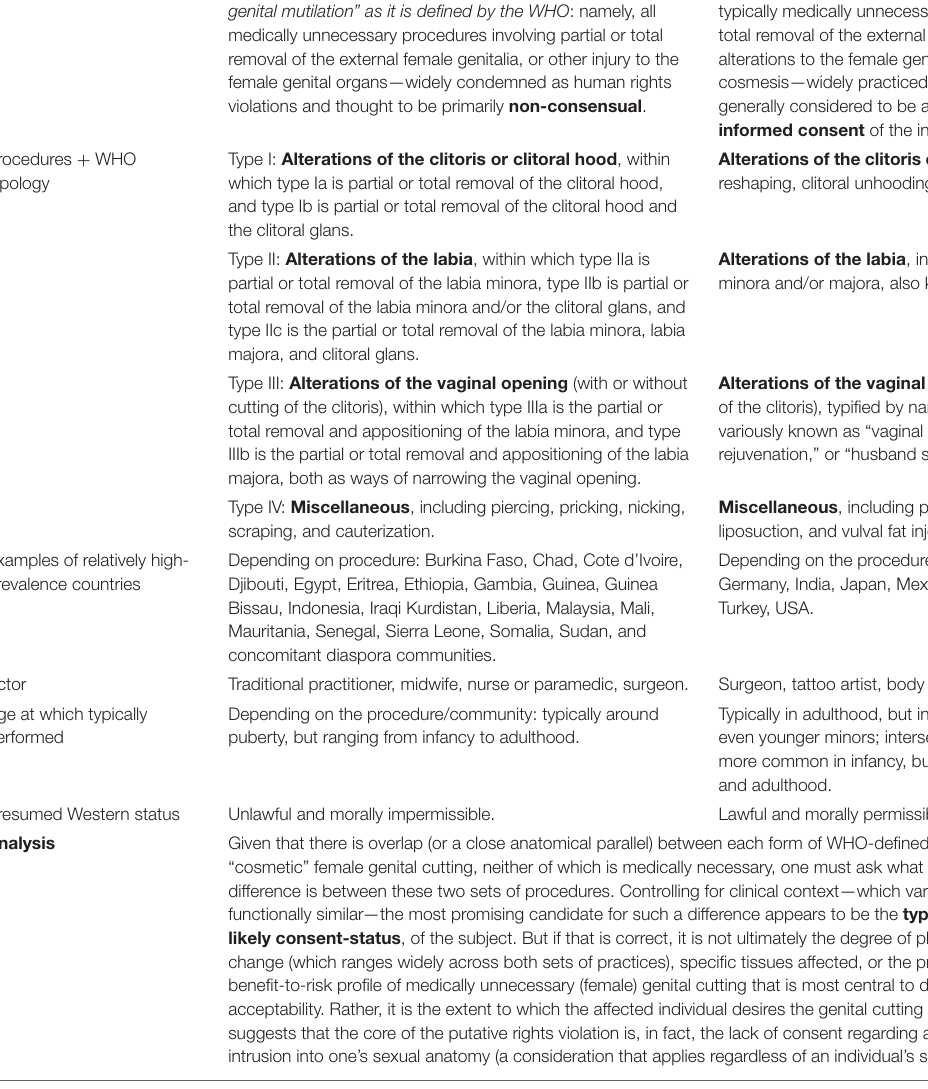
TABLE 1 | Non-Western-associated female genital “mutilation” (Global South) vs. Western-associated “cosmetic” female genital cutting (Global North); adapted from BCBI (2019) and Shahvisi and Earp (2019); internal references ommitted. Category +